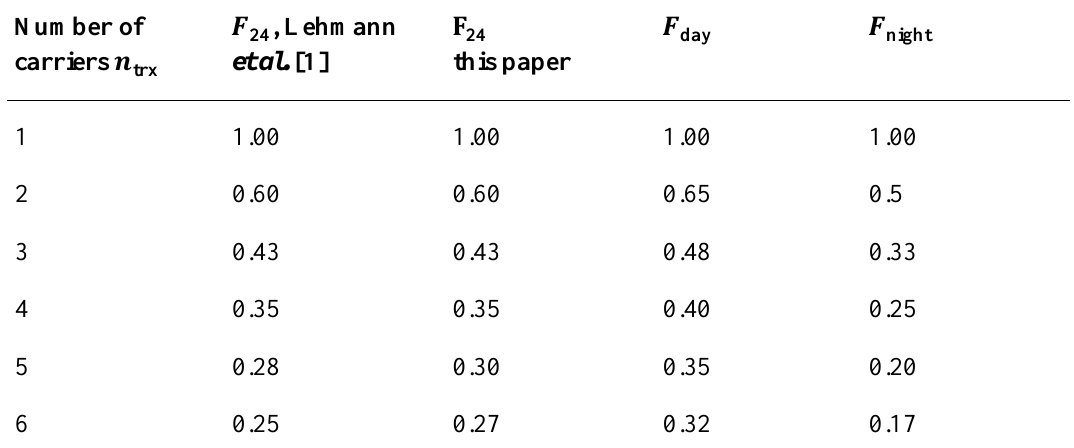
Table 1. Estimated duty factors for GSM cells as a function of the number of carriers in the cell. Number of carriers 𝒏